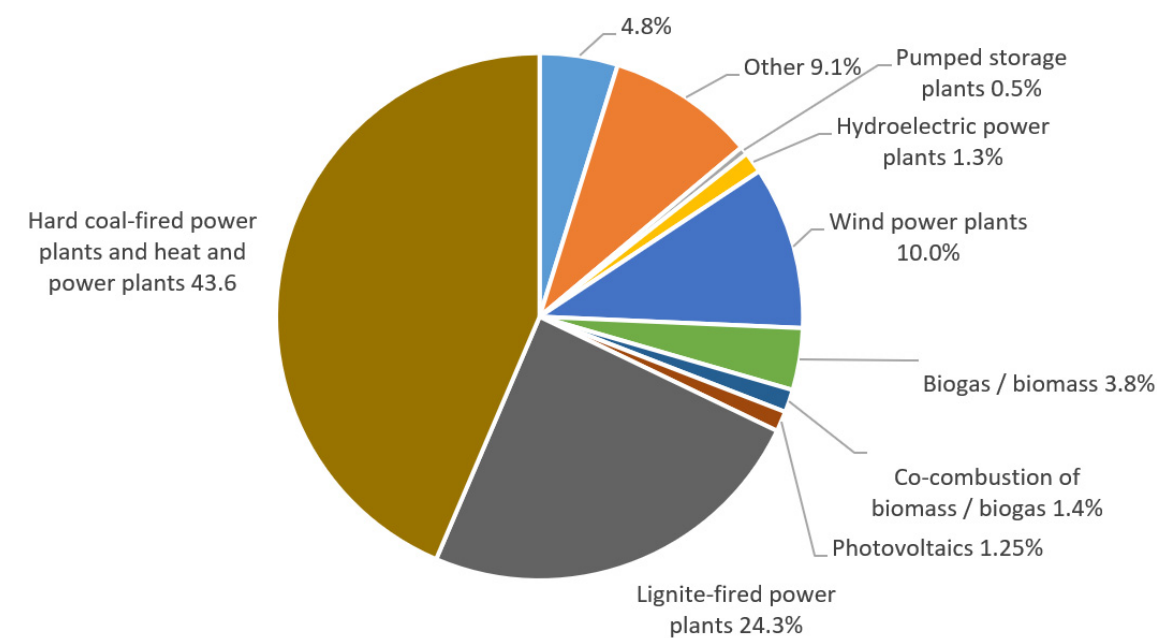
Figure 2. Structure of electricity production (January–December 2020).